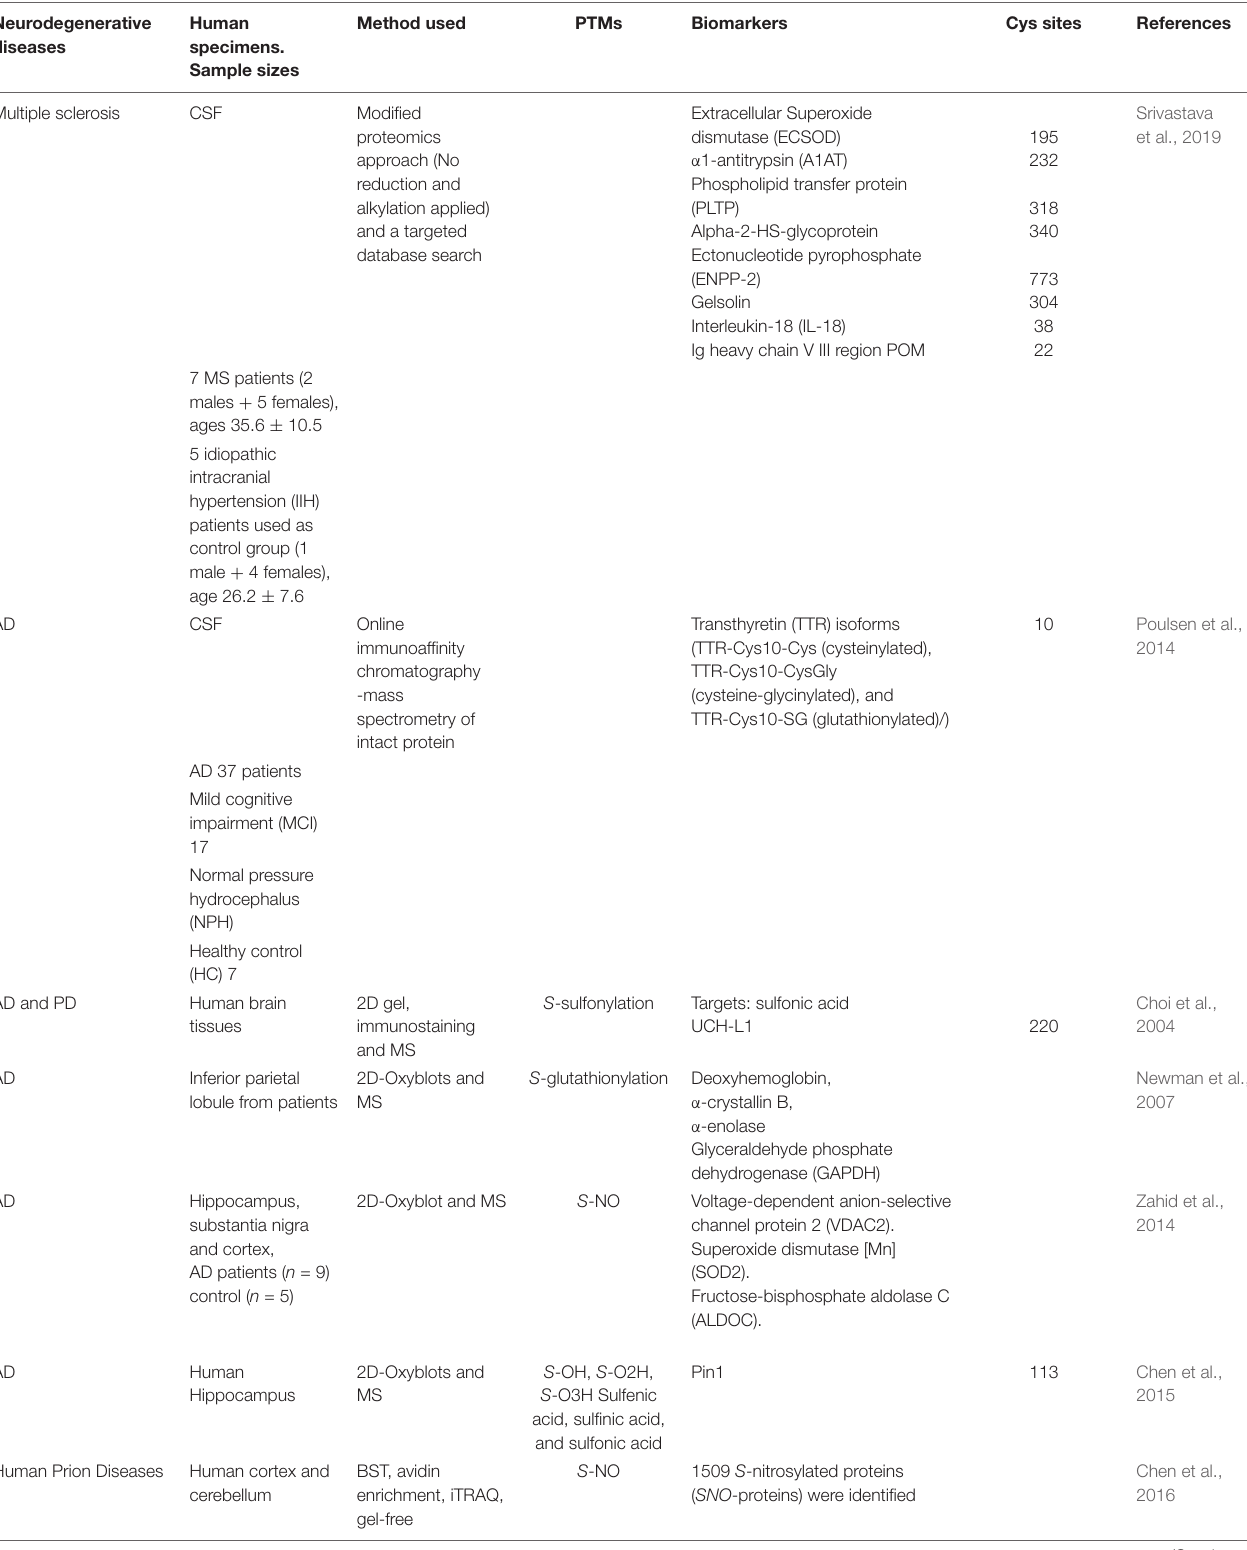
TABLE 2 | List of (potential and confirmed) biomarkers in neurodegenerative diseases from Oxy-Cys proteomics studies. Neurodegenerative Human diseases